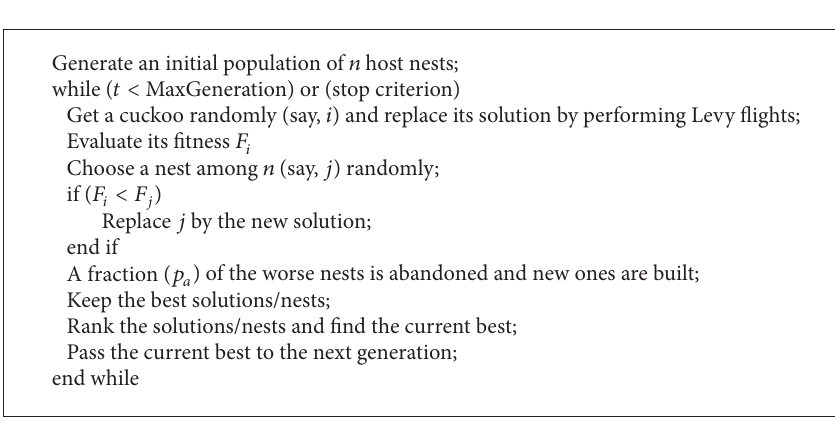
Pseudocode 2: Pseudocode for CS.